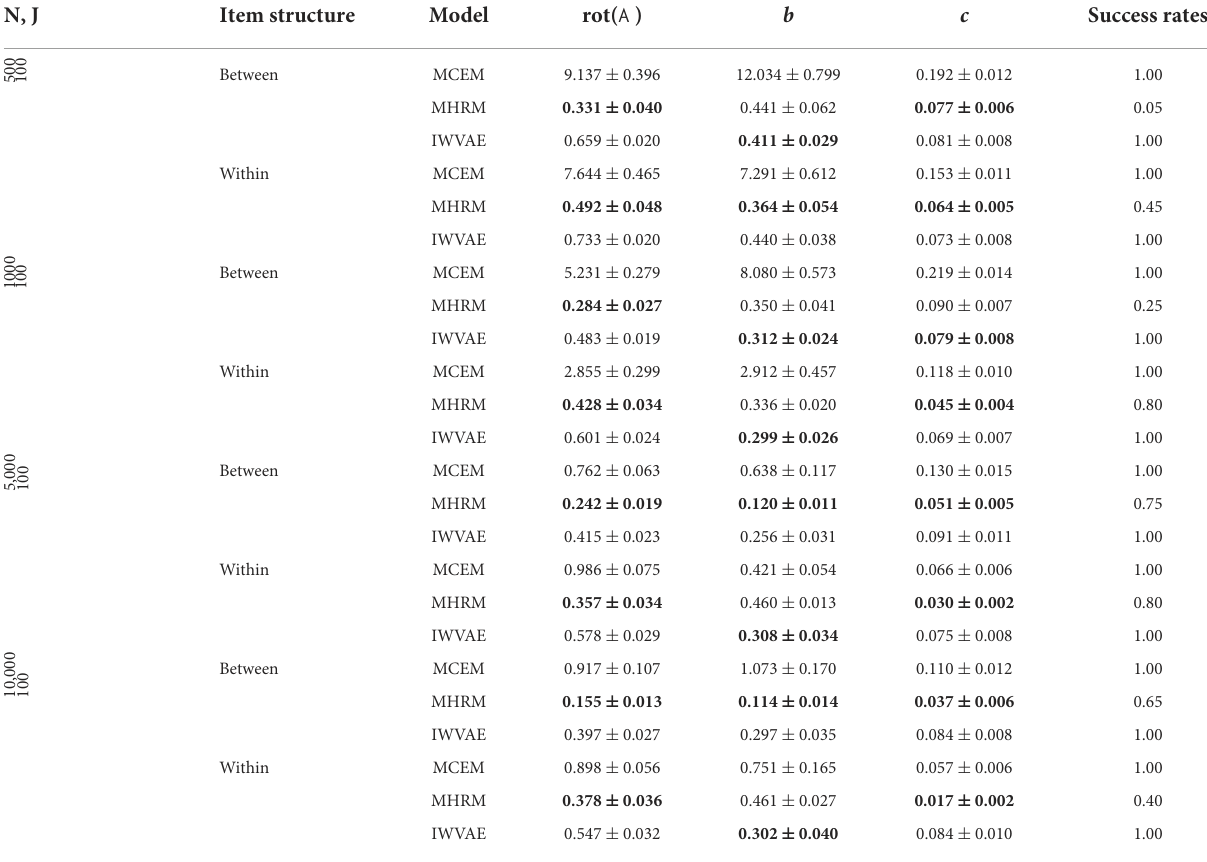
TABLE 7 Mean and SE of RMSE of M p estimate on M3PL models under single regime setting, best results are in bold. N, J Item structure Model c Success